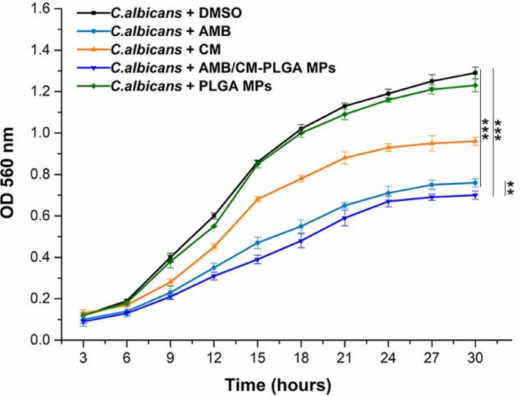
Figure 5. Growth kinetics of C. albicans in the presence of antifungal agents. Effect of AMB, CM, and AMB/CM-PLGA MPs at their MIC/2 concentrations on the growth of C. albicans . Growth curve plotted against absorbance at 560 nm. ** p < 0.05. *** p <